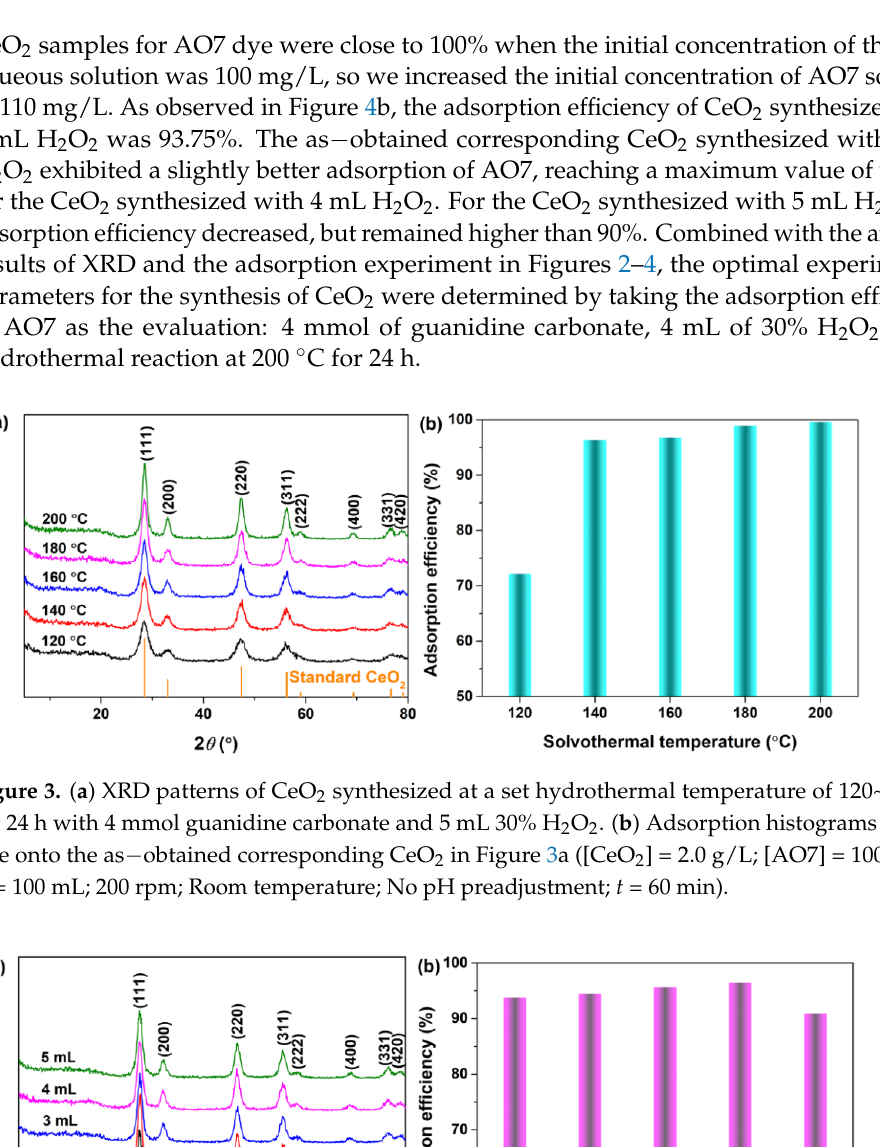
Figure 4. ( a ) XRD patterns of the hydrothermally synthesized CeO 2 at 200 °C 24 h with 4 mmol guanidine carbonate and different additions of 30% H 2 O 2 (1~5 mL). ( b ) Adsorption histograms of AO7 dye onto the as − obtained corresponding CeO 2 in Figure 4a ([CeO 2 ] = 2.0 g/L; [AO7] = 110 mg/L; V = 100 mL; 200 rpm; Room temperature; No pH preadjustment; t = 60 min).